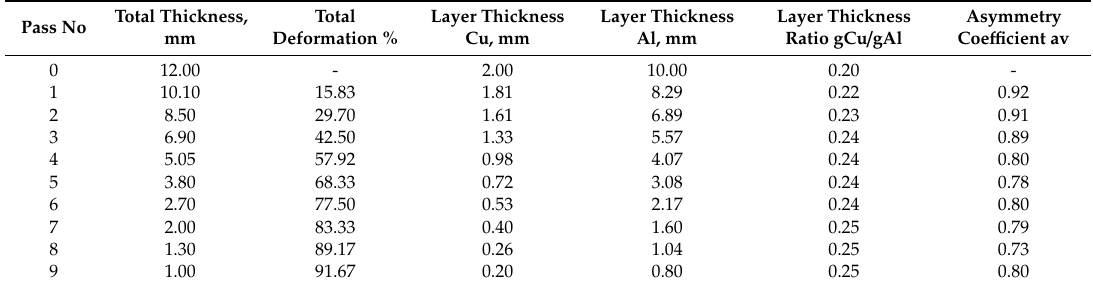
Table 2. Results and parameters for asymmetrical rolling process.